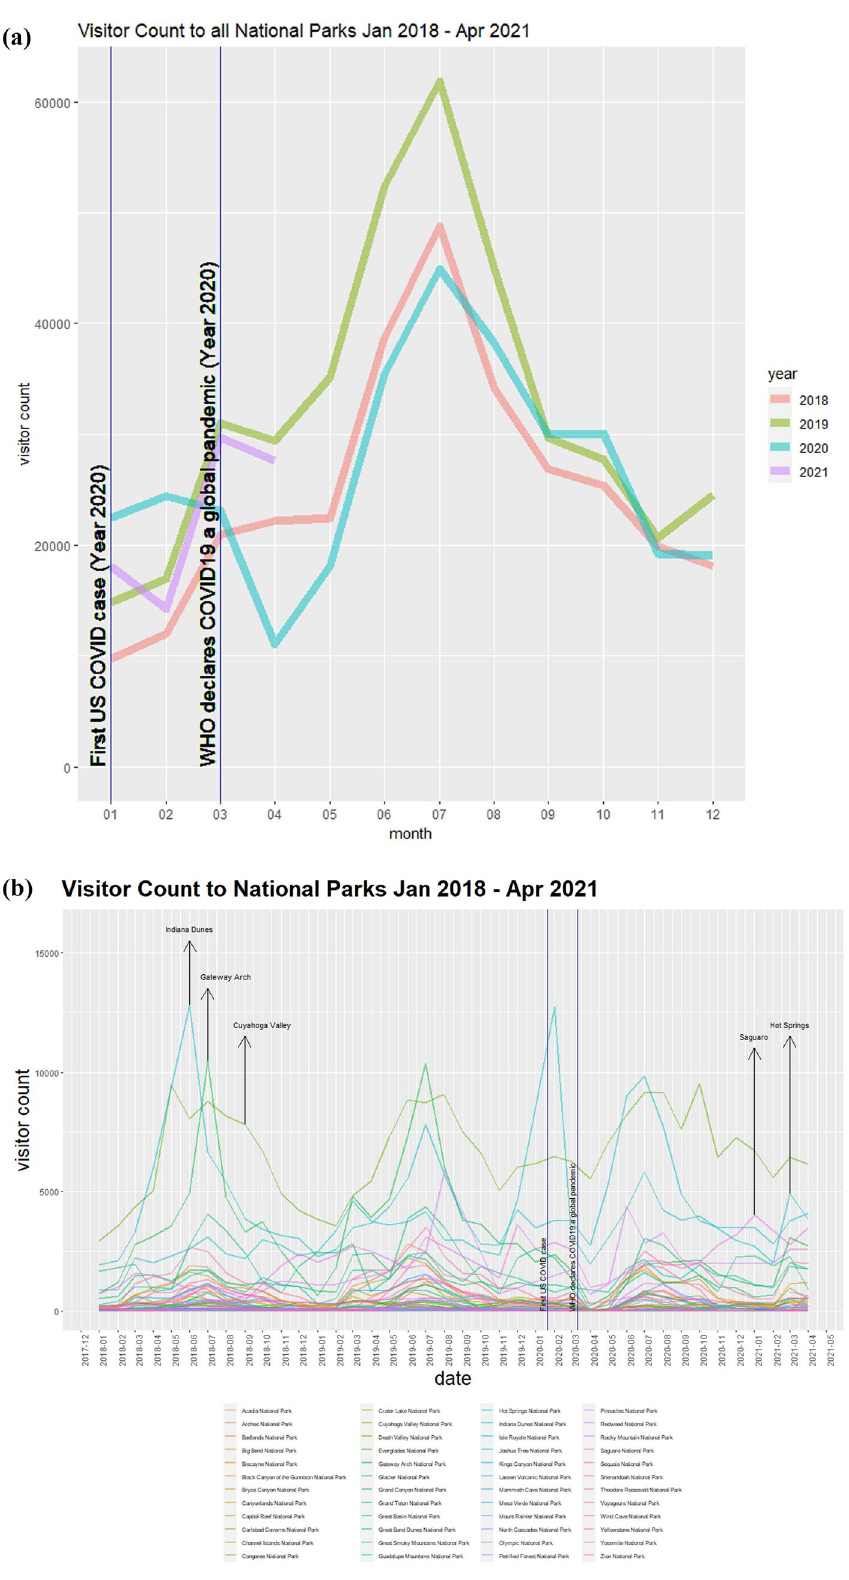
Figure 1. Overall visitation trends from Jan 2018 to Apr 2021. ( a ) On the top compares the changes in visitations from each year from 2018 to 2021 in visitations of all national parks. ( b ) On the bottom compares the changes in visitations for each national